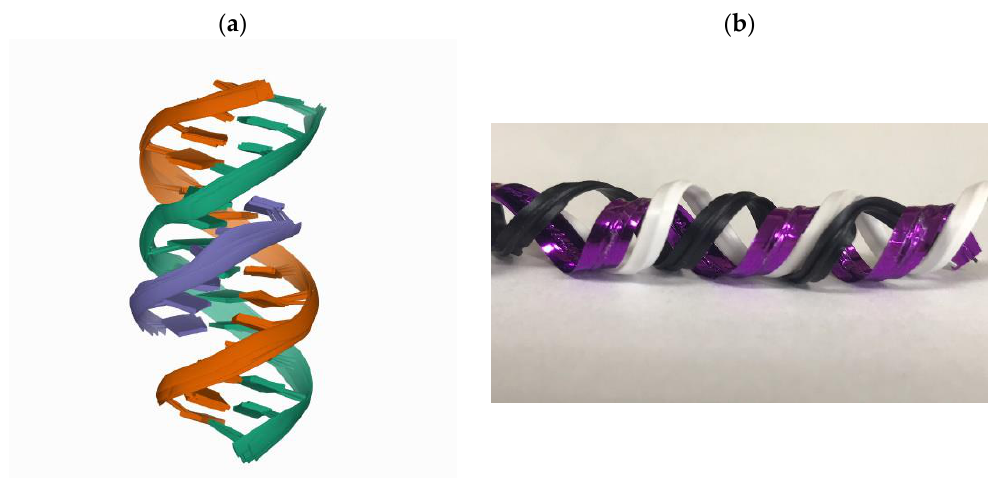
Figure 1. ( a ) A triplex helix structure plotted from RCSB protein data bank (https://www.rcsb.org/ accessed on 1 May 2021). ( b ) A triplex helix structure model.